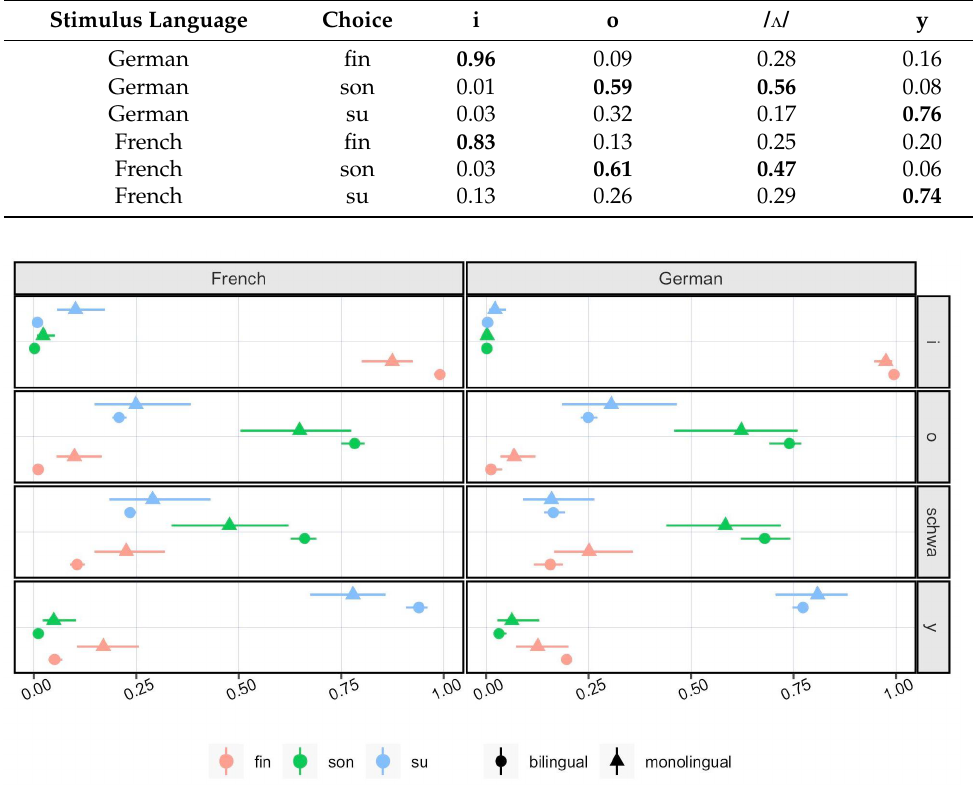
Figure 7. A comparison of the probability and conditional probability of each word choice per stimulus per language in the Spanish monolingual group and L1 Spanish bilingual group. Table 8. Most probable responses given /i/ in French and German by L1 Spanish monolinguals and L1 Spanish